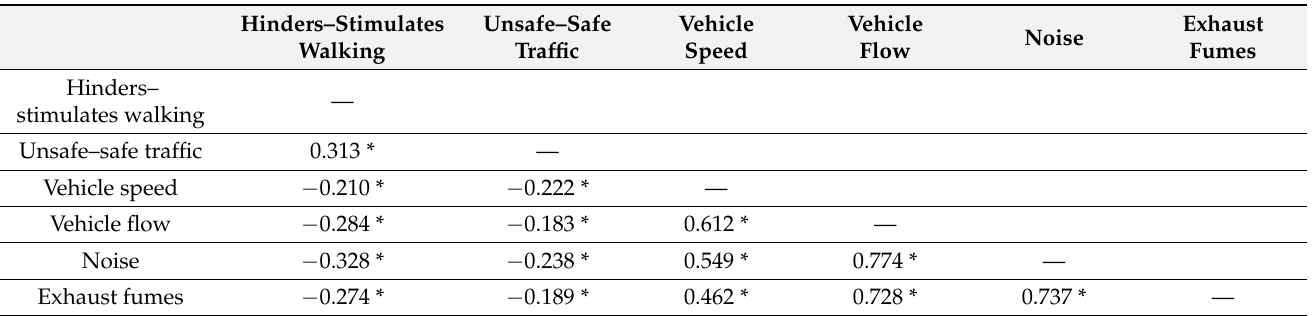
Table 4. Correlation matrix for the environmental variables (r).